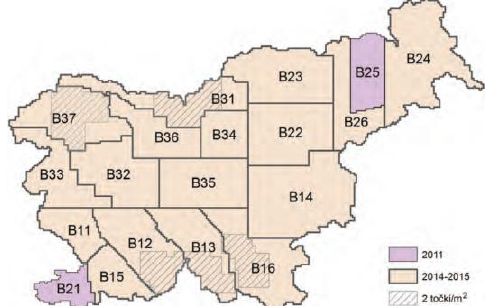
Figure 8: Republic of Slovenia divided into laser scanning blocks (figure adopted from Triglav et al.,